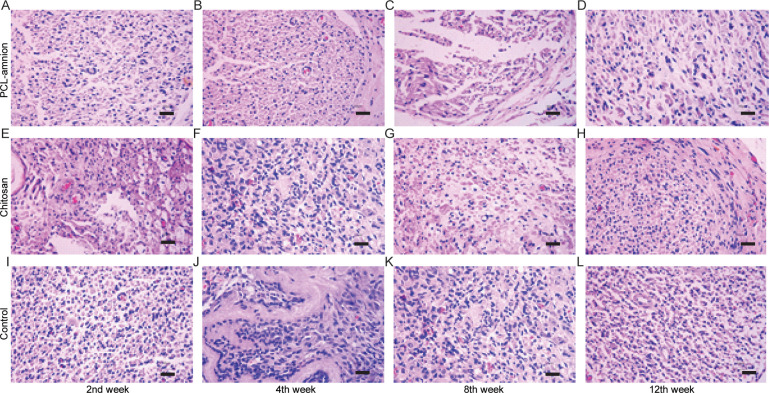
H&E staining of nerve tissue in the three groups at each time point (x400).(A-D) The PCL-amnion group. (E-H) The chitosan group. (I-L) The control group. Scale bar = 50 μm.